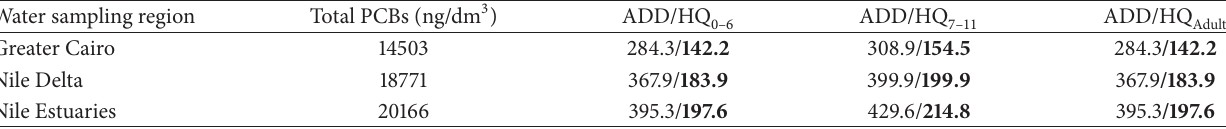
Table 2: Individual average daily doses (mg/kg −1 /d −1 ) and hazard quotients of monitored PCBs, according to the age